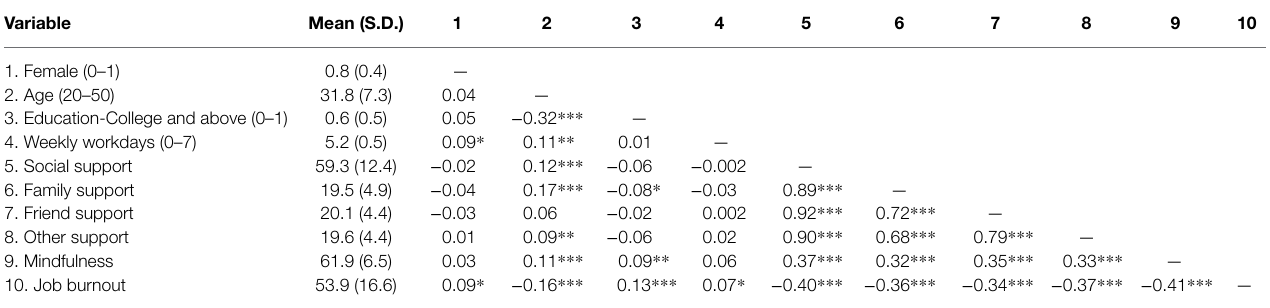
TABLE 1 | Descriptive statistics and correlations of key variables. Variable